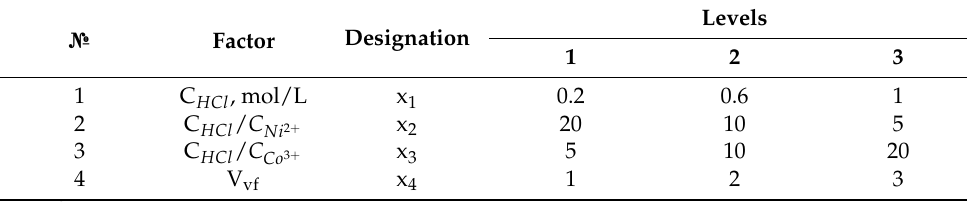
Table 4. Levels of factors studied and ranges of variation.